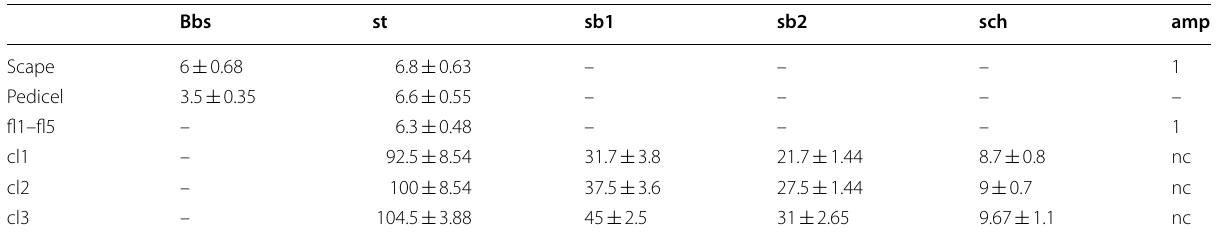
Table 2 Mean number (SE) of different types of sensilla found on the scape, pedicel and flagellomeres of the funicle (fl1–fl5) and ± club (cl1–cl3) of the antenna of adult Rhyzopertha dominica ( n